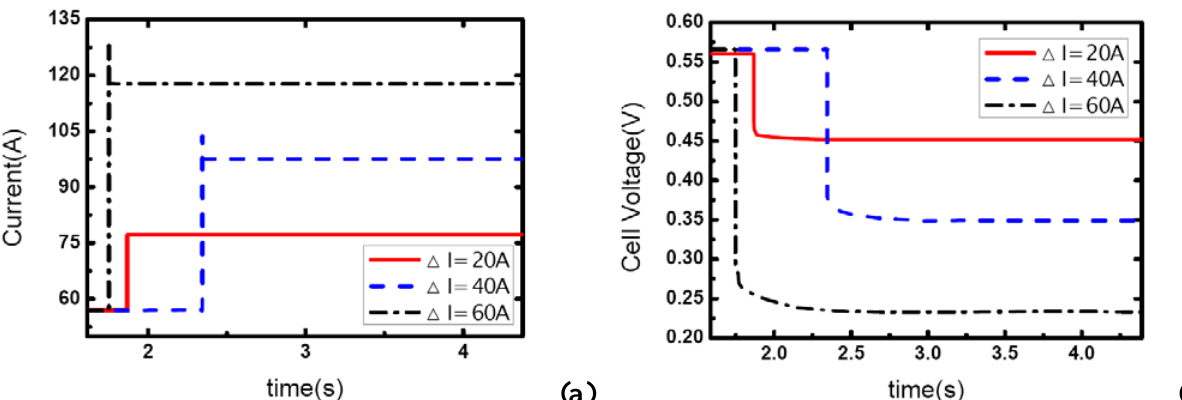
Figure 3. (a) Current change as three different step amplitudes while λ from 5 to 2.43, (b) corresponding dynamic voltage